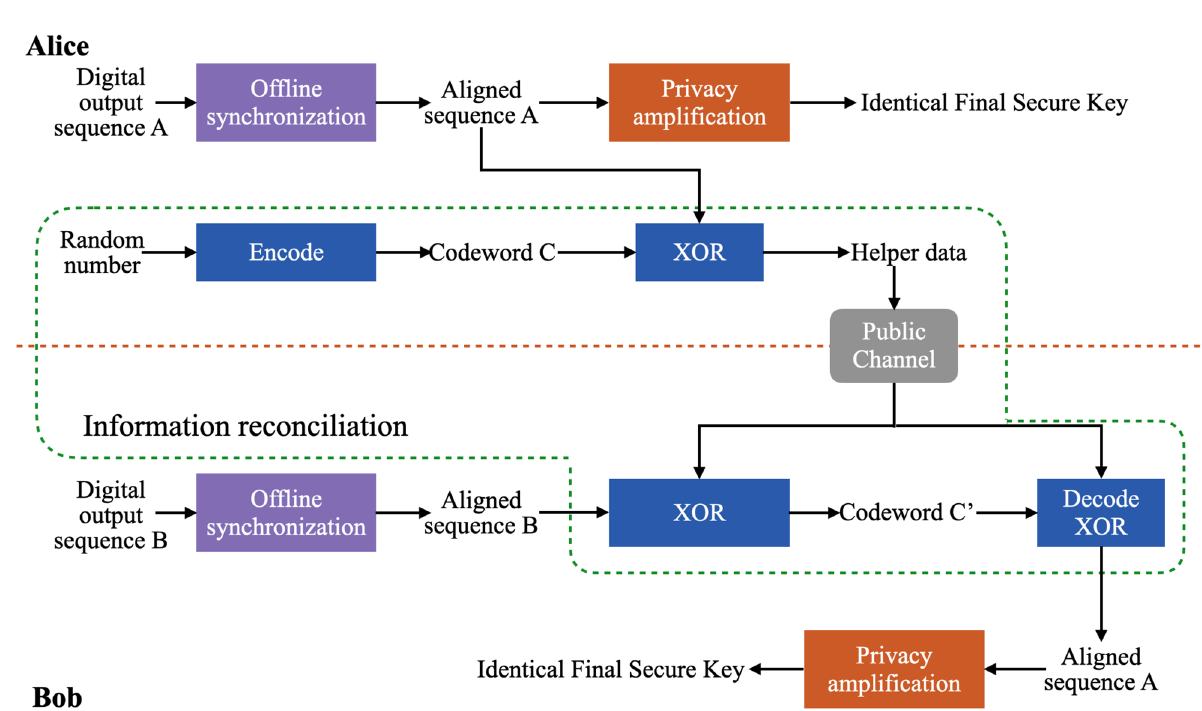
Figure 2. The post-processing procedure for generating identical final secure key using matched superlattice PUF